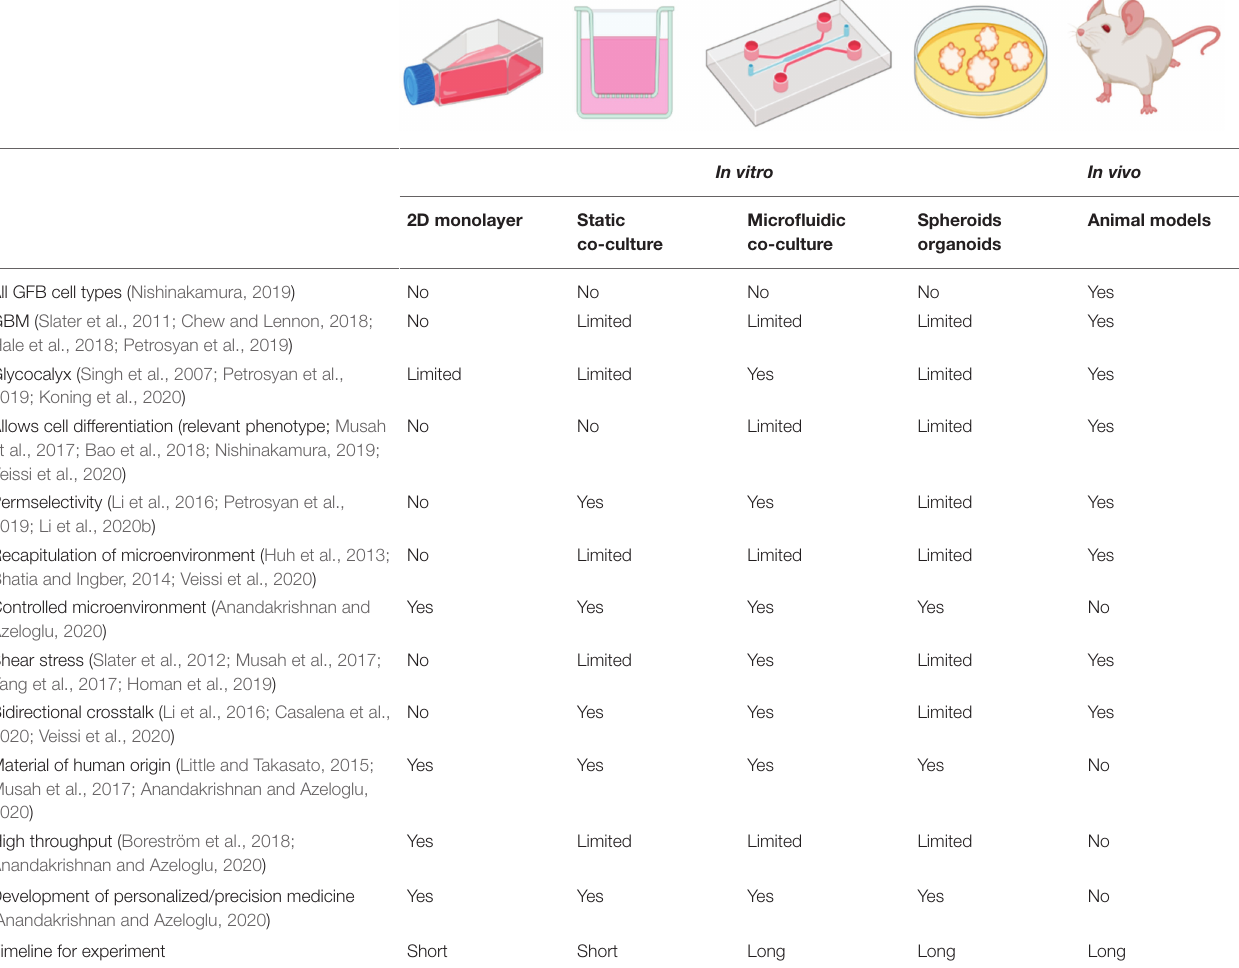
TABLE 1 | Comparison of in vivo and in vitro models currently used or under development for studies of the glomerular filtration barrier (GFB).